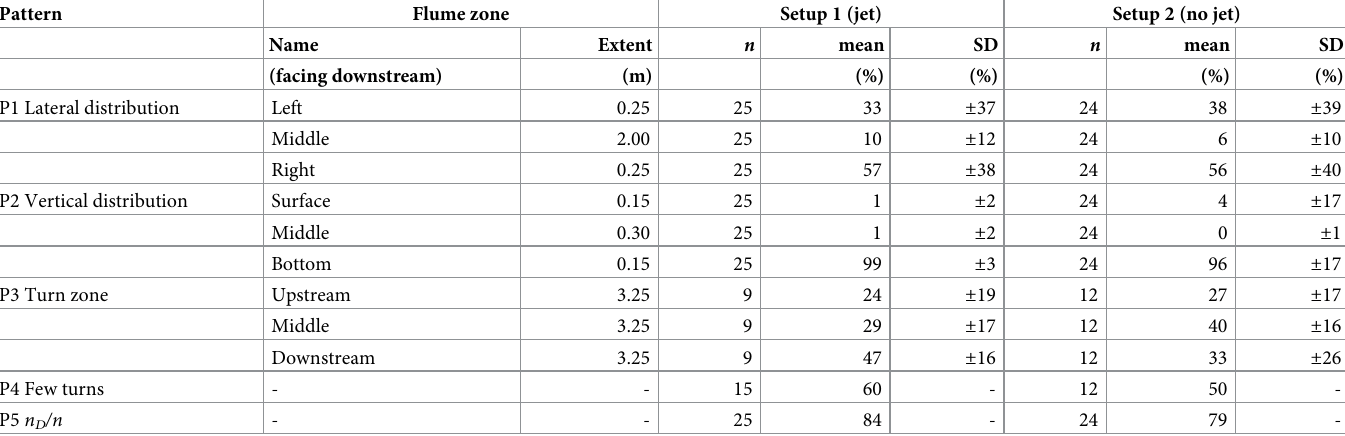
Values rounded to the closest integer. n D and n , number of fish at lines D and A